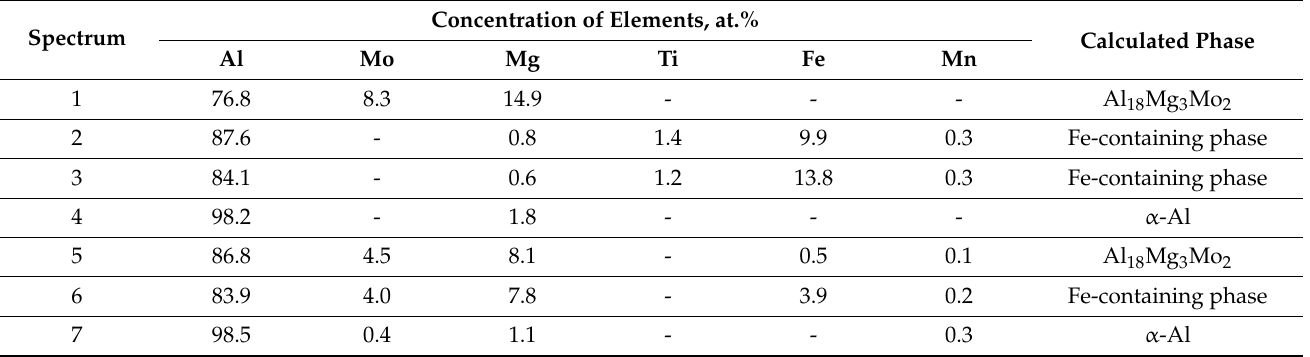
Calculated Phase